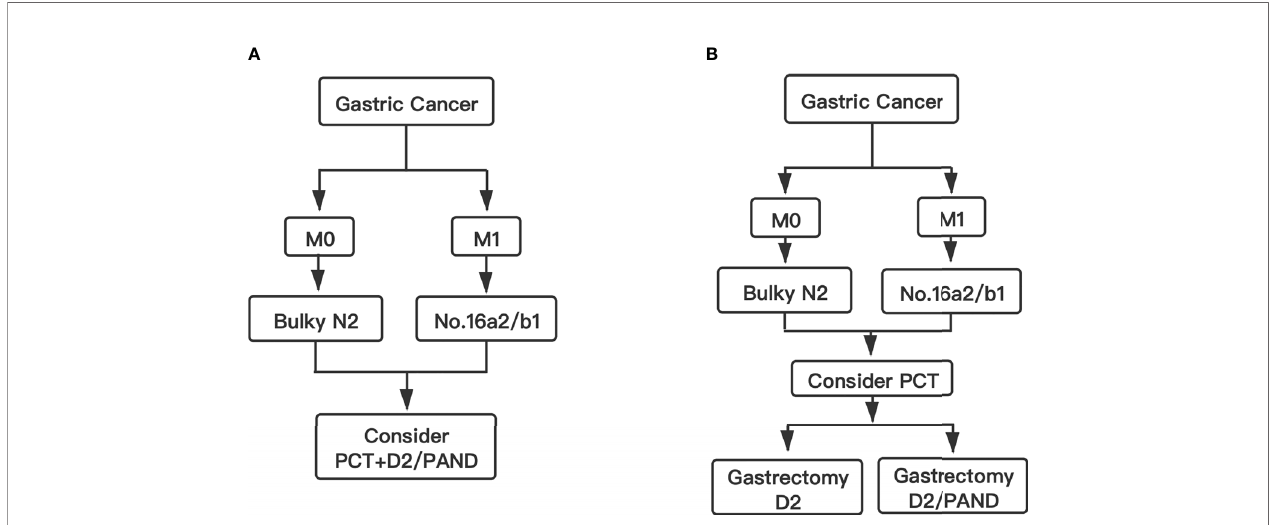
FIGURE 1 | Flow chart. (A) The standard therapy for GC patients with bulky N2 and/or PAN metastases in Japan. (B) The conclusion and suggested therapy for GC patients with bulky N2 and/or PAN metastases in this